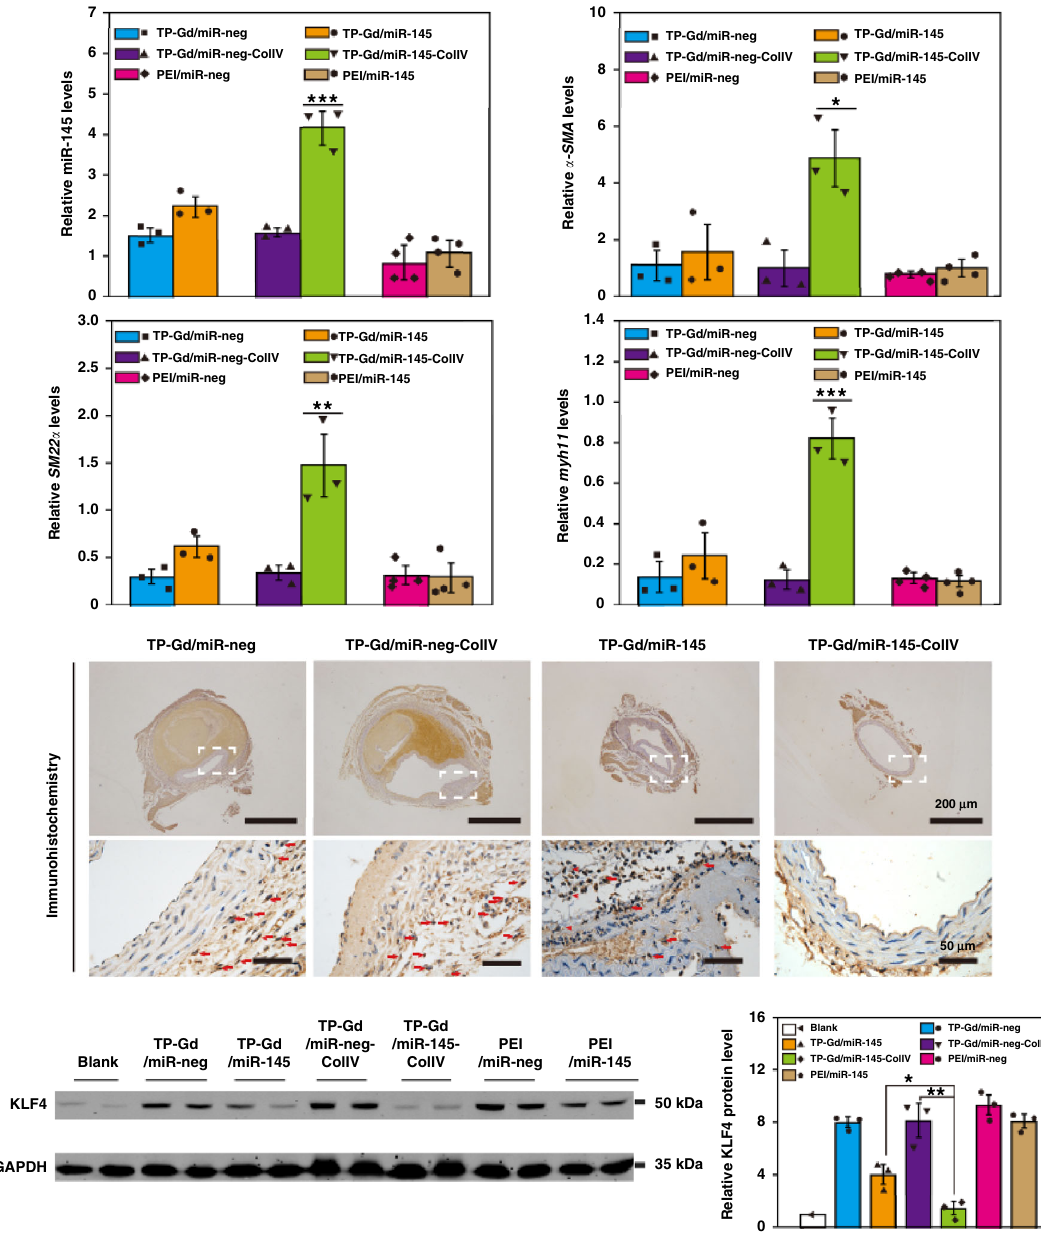
Fig. 6 a Relative miR-145 levels and mRNA expression of α -SMA , SM22 α and myh11 quanti fi ed by PCR assays in thoracic aorta for different groups. b Representative images of KLF4-positive immunohistochemical-stained thoracic aortic arches from all the treated mice (red arrows highlighted positive areas). c Relative KLF4 protein expressions in vivo determined by western blot. (* p < 0.05, ** p < 0.01 and *** p < 0.001, see “ Statistical analysis ” in “ Methods ” ; n ≥ 3 independent experiments; error bars represent standard deviation; source data of a , c are provided as a Source Data fi